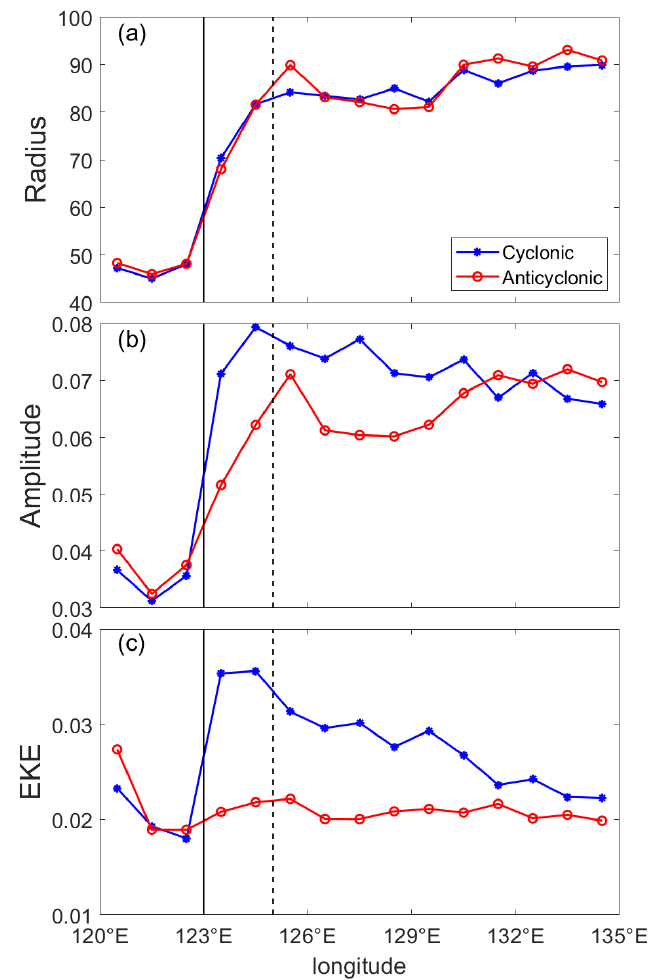
Figure 5. Zonal distribution of ( a ) eddy size (km), ( b ) amplitude (m), and ( c ) the EKE (m 2 /s 2 ) averaged over meridional bands. The width of the bands for averaging is 1 ◦ longitude. The blue curve in each panel represents the parameters of cyclonic eddies, whereas the red curve represents those of anticyclonic eddies. Black solid (dashed) lines are located at 123 ◦ E (125 ◦ E), and eddies west (east) of the solid (dashed) lines are regarded as the same sample data. 3.3. Comparison of Eddy Characteristics between Eddies near the Kuroshio and in the Pacific In- terior To analyze the temporal variability of the eddies throughout their lifespan, we compared the characteristics of the eddies that can propagate to the Kuroshio region and those that decay in the western Pacific interior. In both cases, only eddies with lifespans longer than 6 weeks were chosen for the comparison. Eddies were considered to reach the Kuroshio if the edge of an eddy intersects with 123° E during its lifespan (Figure 1). We normalized each eddy’s age by its lifespan. Similarly, the temporal evolution of the three parameters above was analyzed by normalizing such parameters by subtracting the minimum lifespan, then dividing by the maximum minus the minimum (their range).